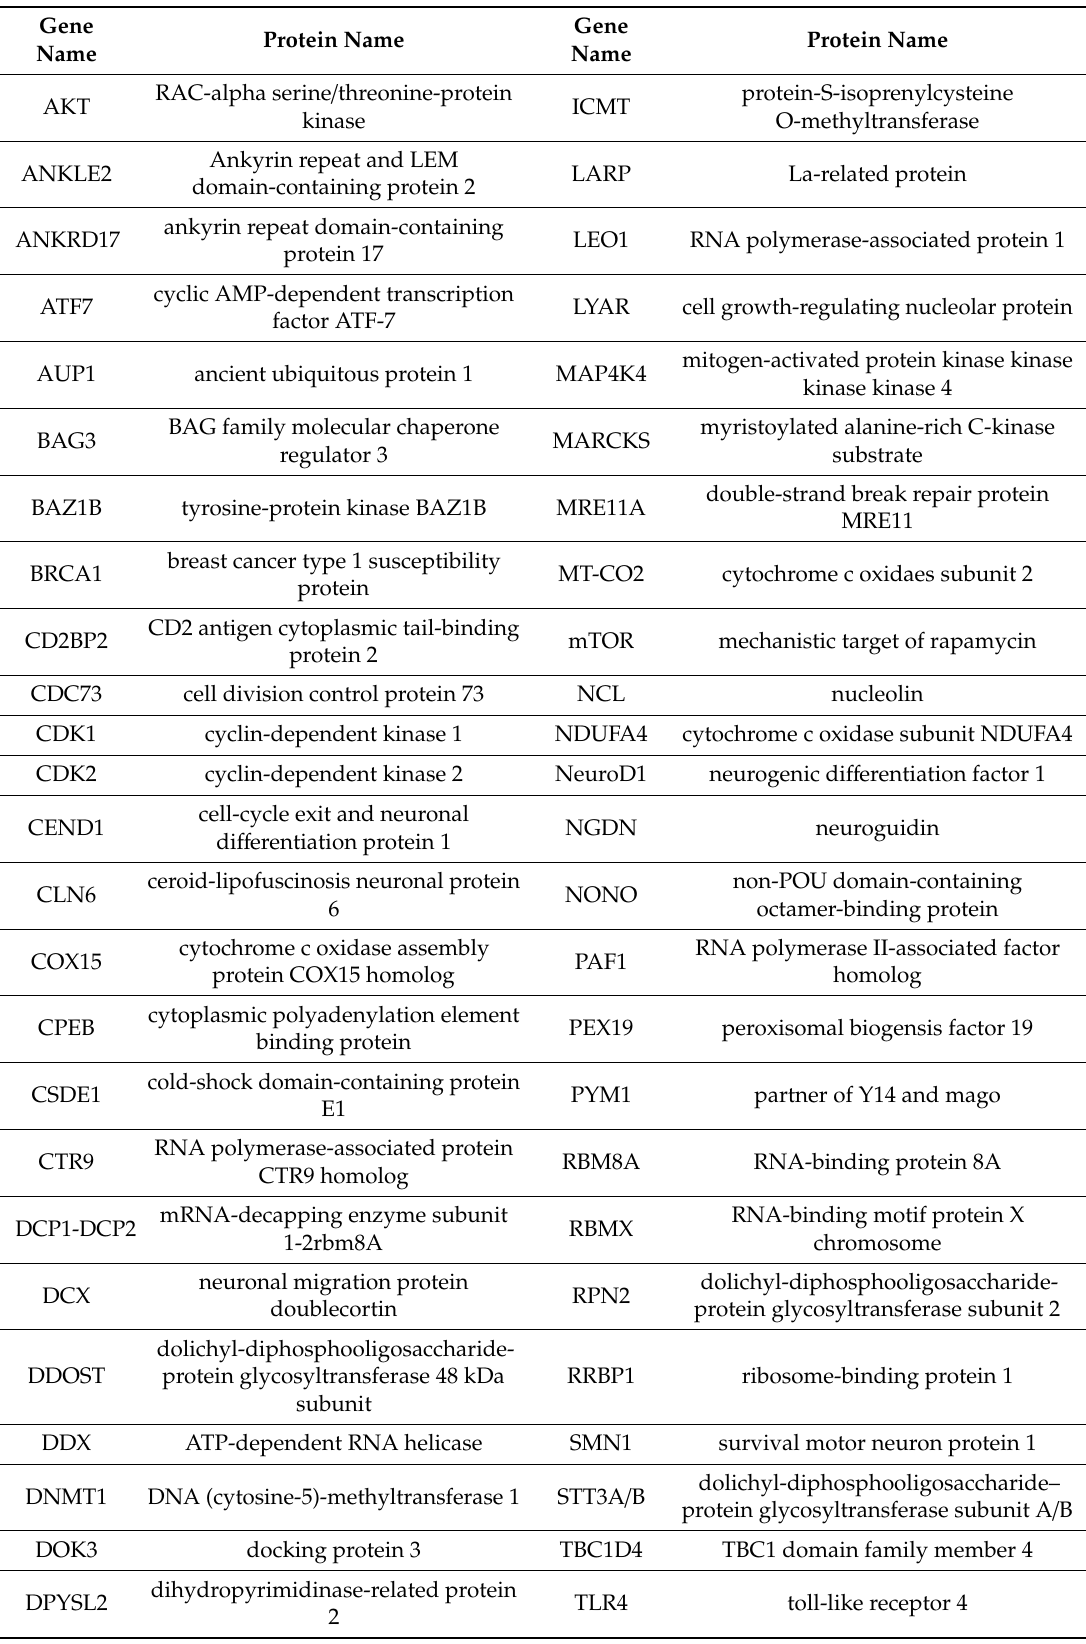
Table 1. Gene names and corresponding full protein names listed in alphabetical order.